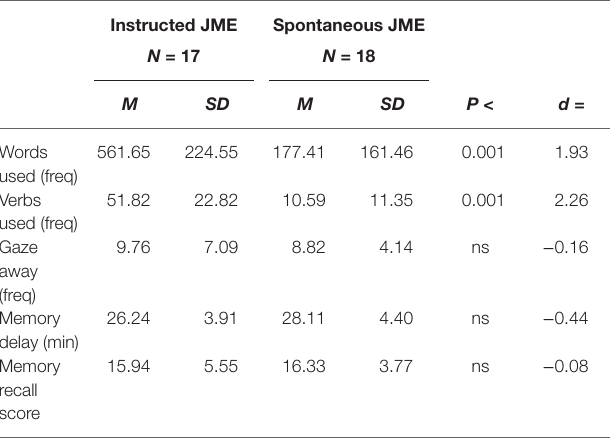
TABLE 2 | Parent verbal interaction, session length, and memory result for the two joint media engagement (JME) intervention groups. Instructed